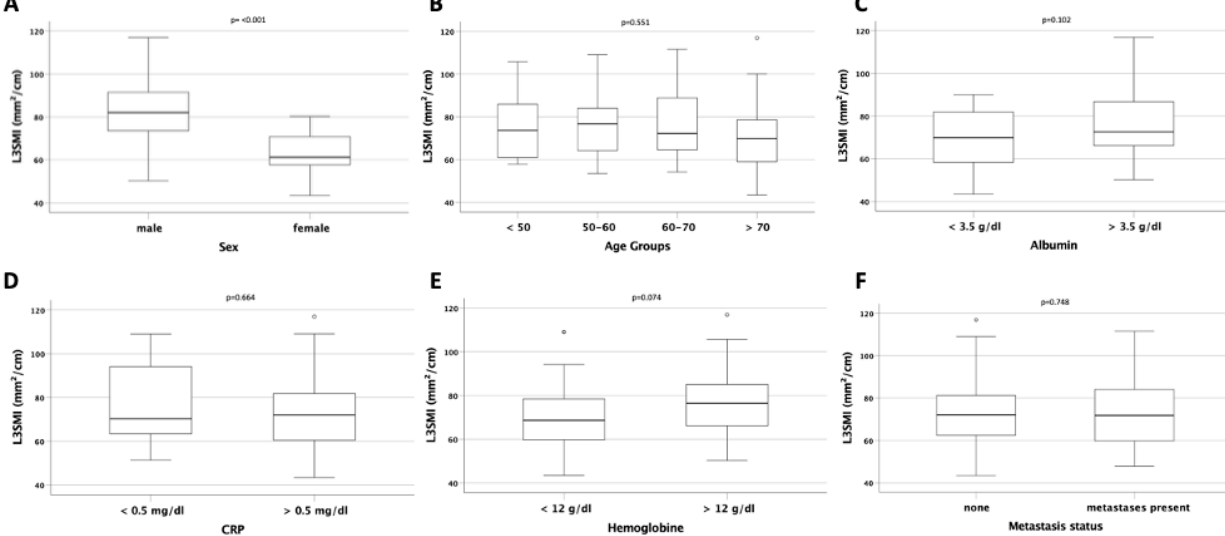
Figure 2. Evaluation of the L3SMI in different patient subgroups. ( A ) Male patients have a significantly higher L3SMI compared to female patients. The L3SMI is unaltered between patients of different age ( B ), with normal or reduced serum albumin levels ( C ) and normal or increased CRP serum levels ( D ). ( E ) Anemic patients show a trend toward a reduced L3SMI compared to non-anemic patients. The L3SMI is unaltered between patients with and without distant metastases ( F